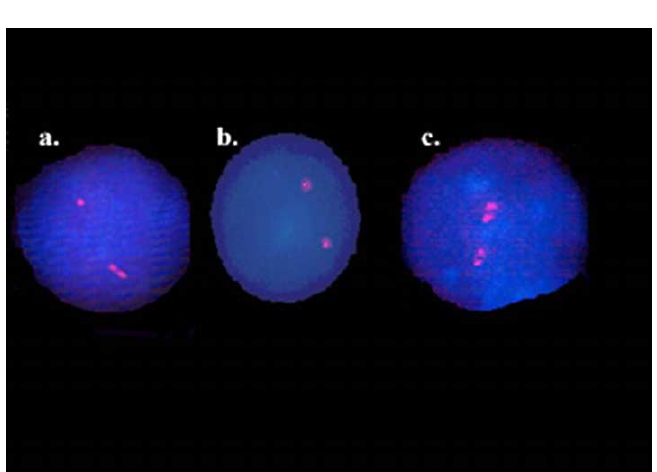
Fig. 1. Analysis of replication timing and asynchrony: (a) a cell in which one sequence has alredy replicated and one has not yet replicated (SD cell); (b) a cell in which neither sequence has replicated (SS cell) – indicating late replication; (c) a cell in which both sequences have already replicated (DD cell) – indicating early